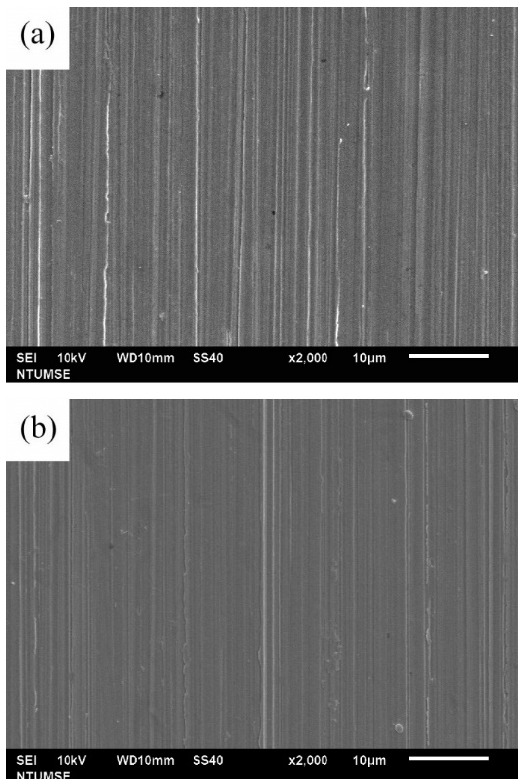
Figure 6. SEM images of the 304 SS surface after ( a ) 12 h and ( b ) 336 h of exposure to the uninoculated culture medium.